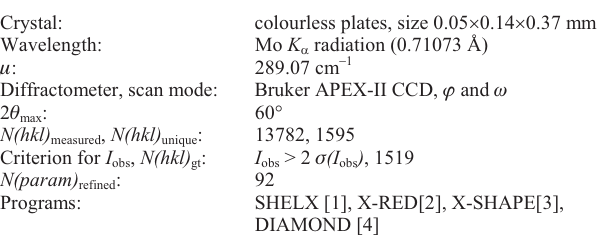
Table 1. Data collection and